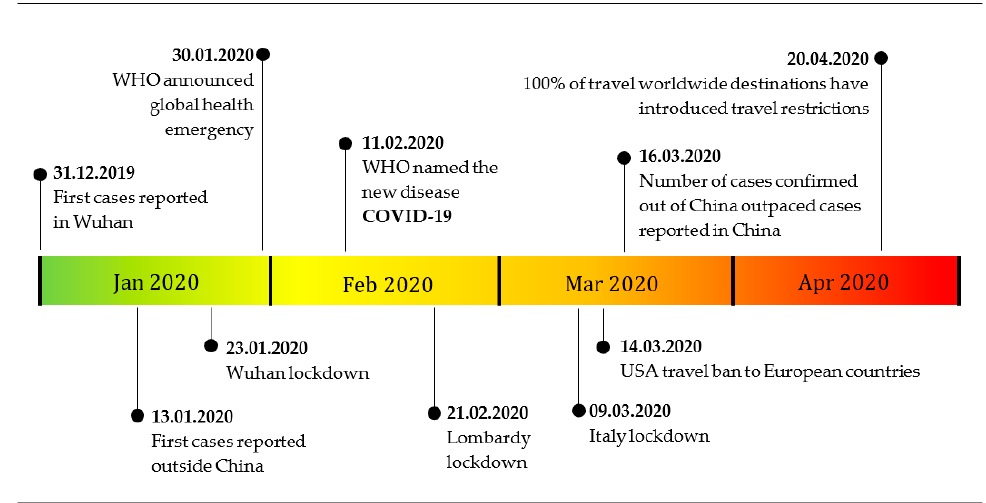
Figure 2. Key dates in the COVID-19 timeline in the first phase of its escalation. Source: own study based on “COVID-19 timeline” by United Nations World Tourism Organization (https://unwto.org) (UNWTO 2020).